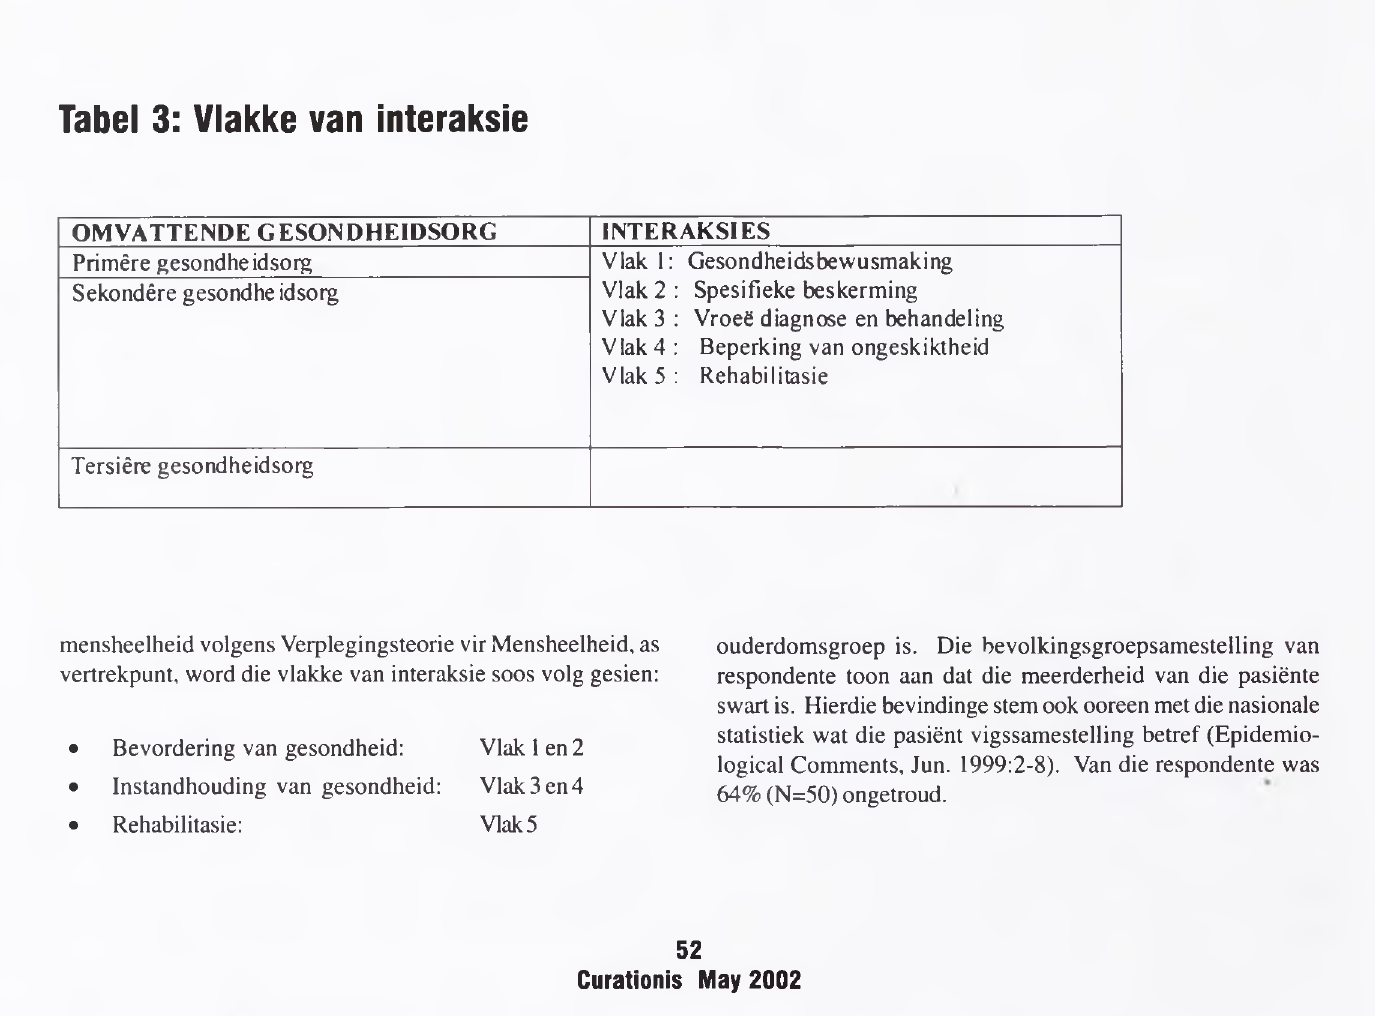
Tabel 3: Vlakke van interaksie OMVATTENDE GESONDHEIDSORG INTERAKSIES Primêre gesondheidsorg Vlakl: Gesondheidsbewusmaking Vlak 2 : Spesifieke